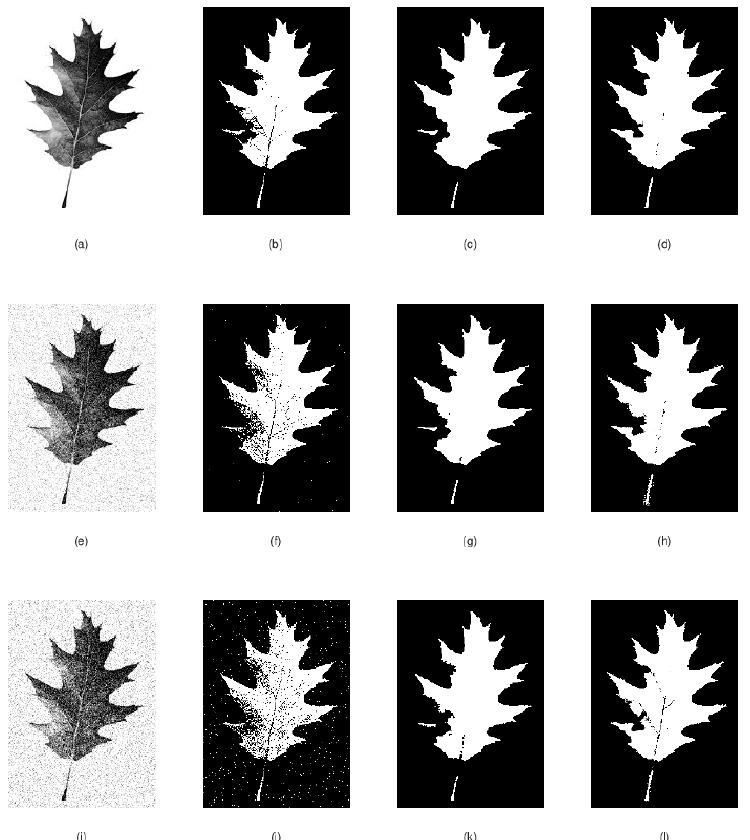
Figure 2. ( a ) Original input image to be segmented; ( b ) K-means segmentation results; ( c ) Chan– Vese segmentation results; ( d ) Our model segmentation results after 2 iterations; ( e ) Input image to be segmented with Gaussian noise added; ( f ) K-means segmentation results for noisy input in ( e ); ( g ) Chan–Vese segmentation results for noisy input in ( e ); ( h ) Our model segmentation results for noisy input in ( e ) after 2 iterations; ( i ) Input image to be segmented with more noise added; ( j ) K-means segmentation results for image in ( g ); ( k ) Chan–Vese segmentation results for noisy input in ( g ); and ( l ) Our model segmentation results for noisy image in ( g